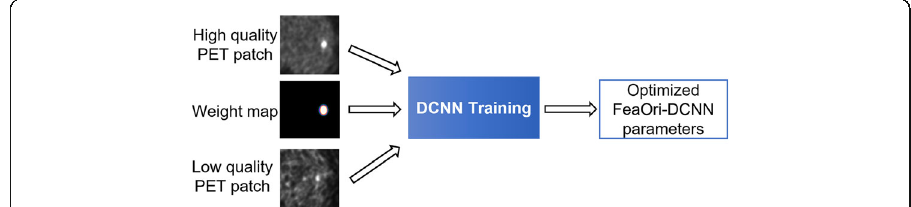
Fig. 2 Overview of the feature-oriented deep convolutional neural network. Overview of the feature- oriented deep convolutional neural network training to better preserve small features in output. The weight map is used to assign different weights to different voxels in the loss function calculation. In this case, a higher weight is assigned to voxels in the